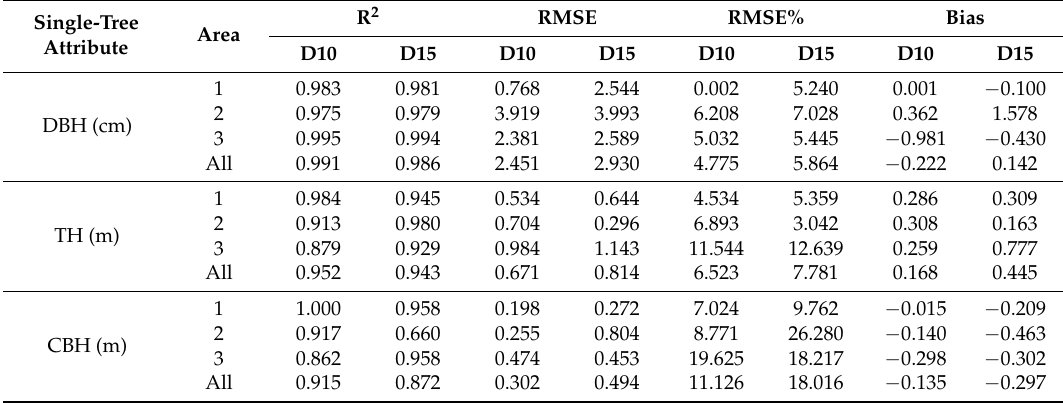
Table 5. Summary statistics of single-tree attributes (DBH, TH, and CBH) estimated by D10 and D15